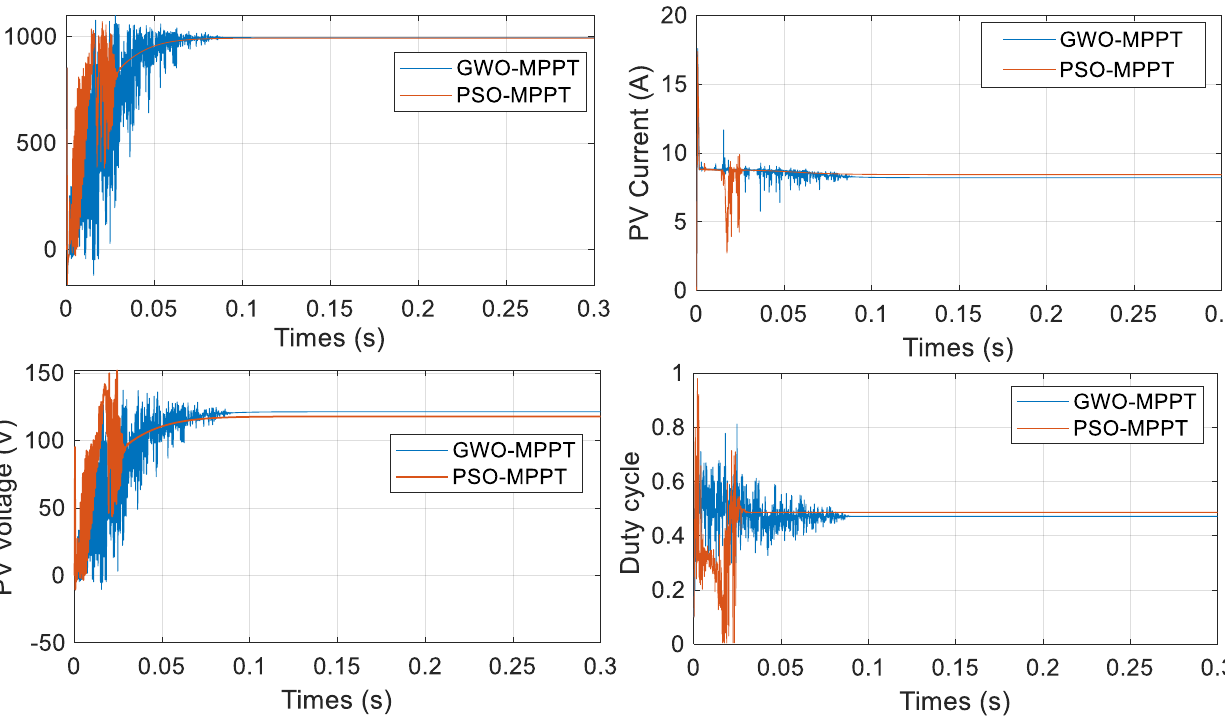
Figure 10. PV characteristics under uniform irradiation: 0% partial shading.